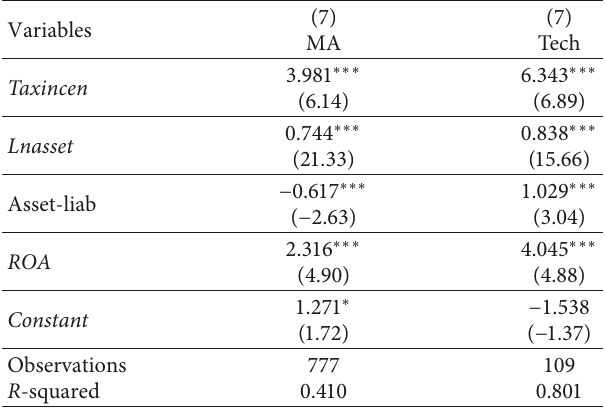
Table 7: Tax incentive policies-innovation input (industry)